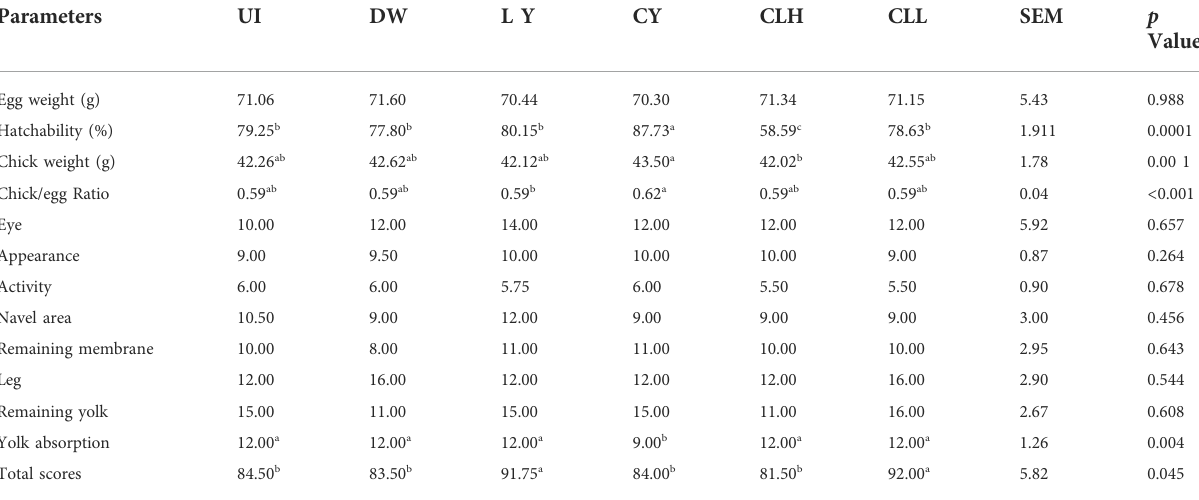
TABLE 1 Effect of in ovo cysteine and lysine on hatchability and chick quality at hatch. Parameters